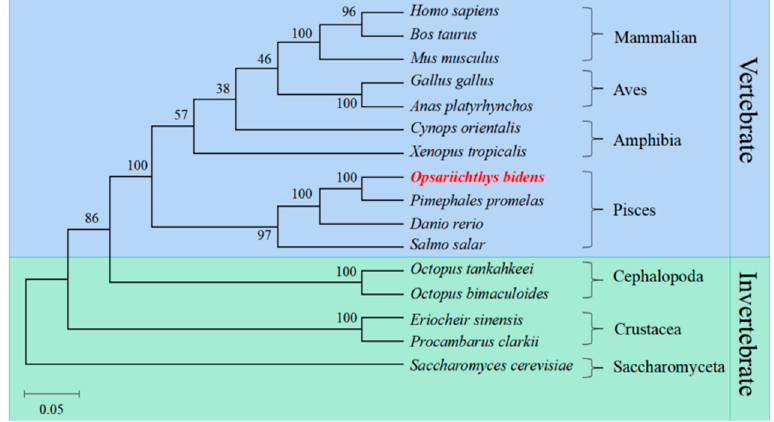
Figure 6. Phylogenetic tree based on PHB amino acid sequence. The putative Ob -PHB formed a sub-franch with fish PHB.